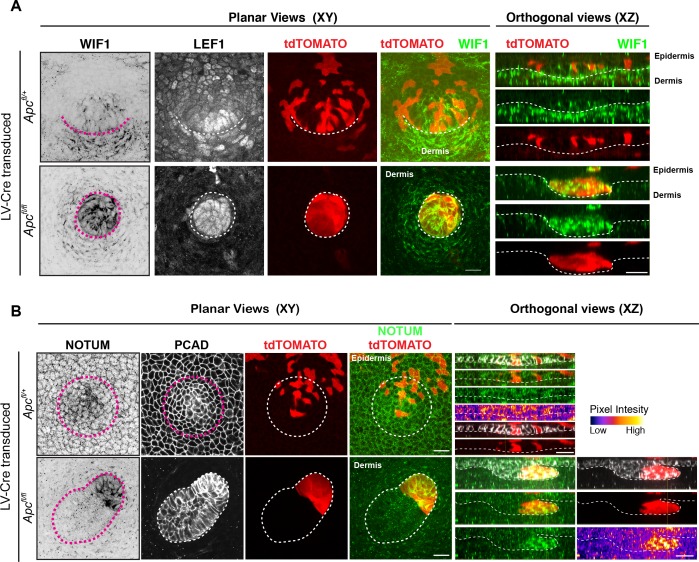
Apc-null cells express high levels of WNT inhibitors.(A–B) Representative immunofluorescence images and respective orthogonal views from Apc-null and Apc-het transduced tdTomato+ embryonic skins showing endogenous (A) WIF1 and (B) NOTUM patterns. Note strong expression of WNT inhibitors NOTUM and WIF1 in Apc-null clusters, despite presence of nuclear LEF1 and robust WNT signaling. Circular dashed line in Apc-het outlines a placode. Dotted lines demarcate epithelial-mesenchymal boundaries. The XY axis is planar to the epidermis; the XZ axis shows sagittal views perpendicular to the skin surface. Scale bars, 20 μm.